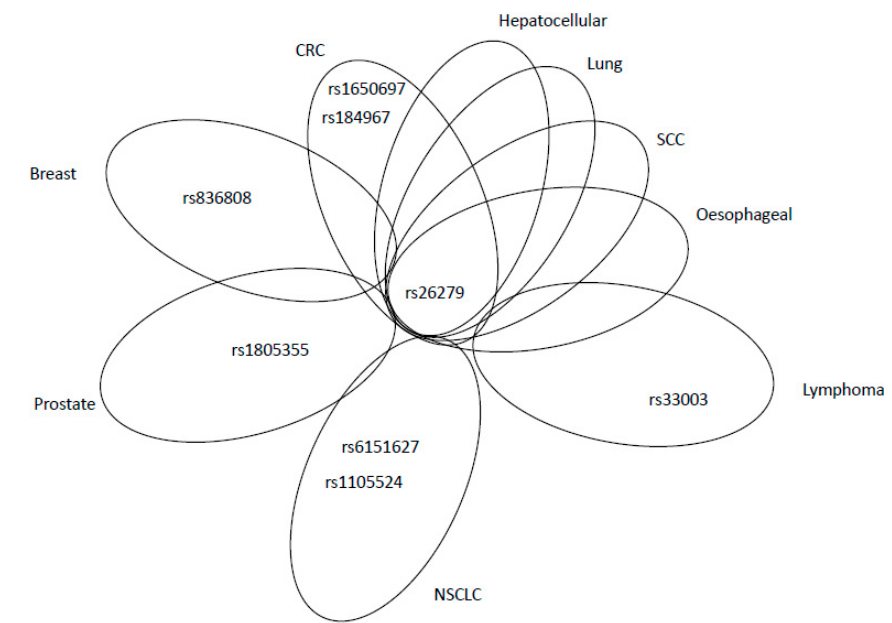
Figure 7. Venn diagram showing relevant MSH3 SNPs associated with adverse effects, in overlap among different cancer types or peculiar for specific malignancies. CRC: colorectal cancer; SCC: squamous cell carcinoma; NSCLC: non-small-cell lung